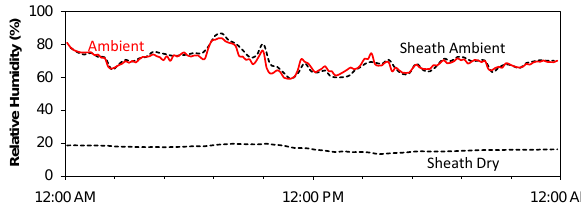
Fig. 3. Example data from midnight on 8 May to midnight on 9 May. Ambient RH (red) and sheath dry/ambient (black